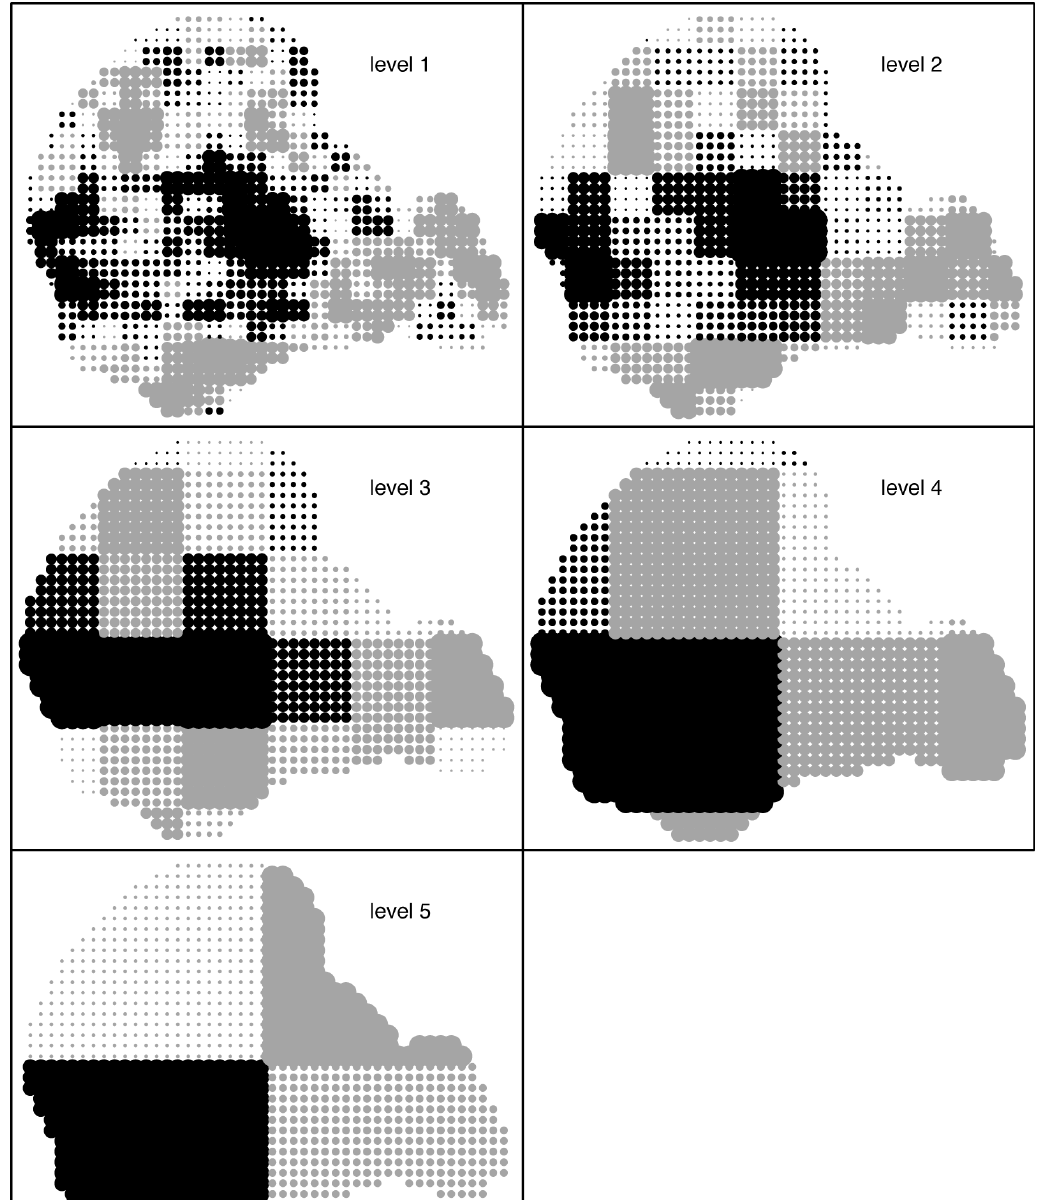
Fig. 4. Smooth parts of OLS residuals on different resolution lev- els for one realization of the data with normally distributed re- sponses. Scaling is different for every